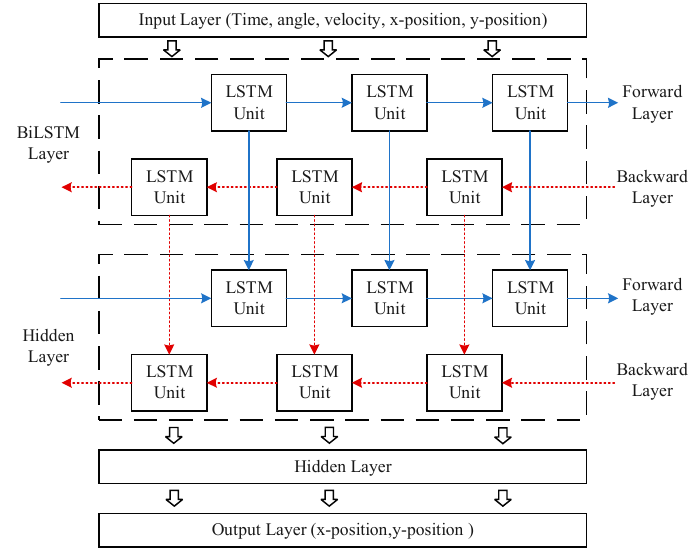
Figure 3. BiLSTM architecture.